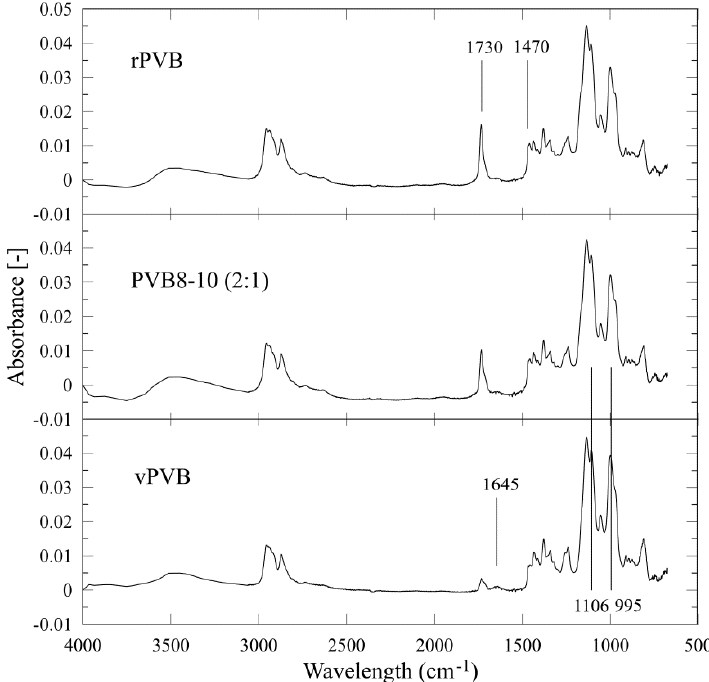
Figure 9. Attenuated total reflection FTIR spectra of the selected PVB nanofibrous webs. Table 4. Characteristic FT-IR spectra of